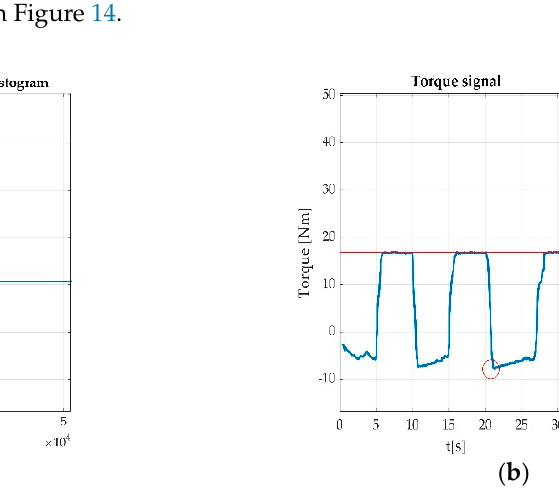
Figure 14. Offset and Peak value detection during acquisitions: ( a ) MVIC during plantar flexion; ( b ) MVIC during dorsiflexion.